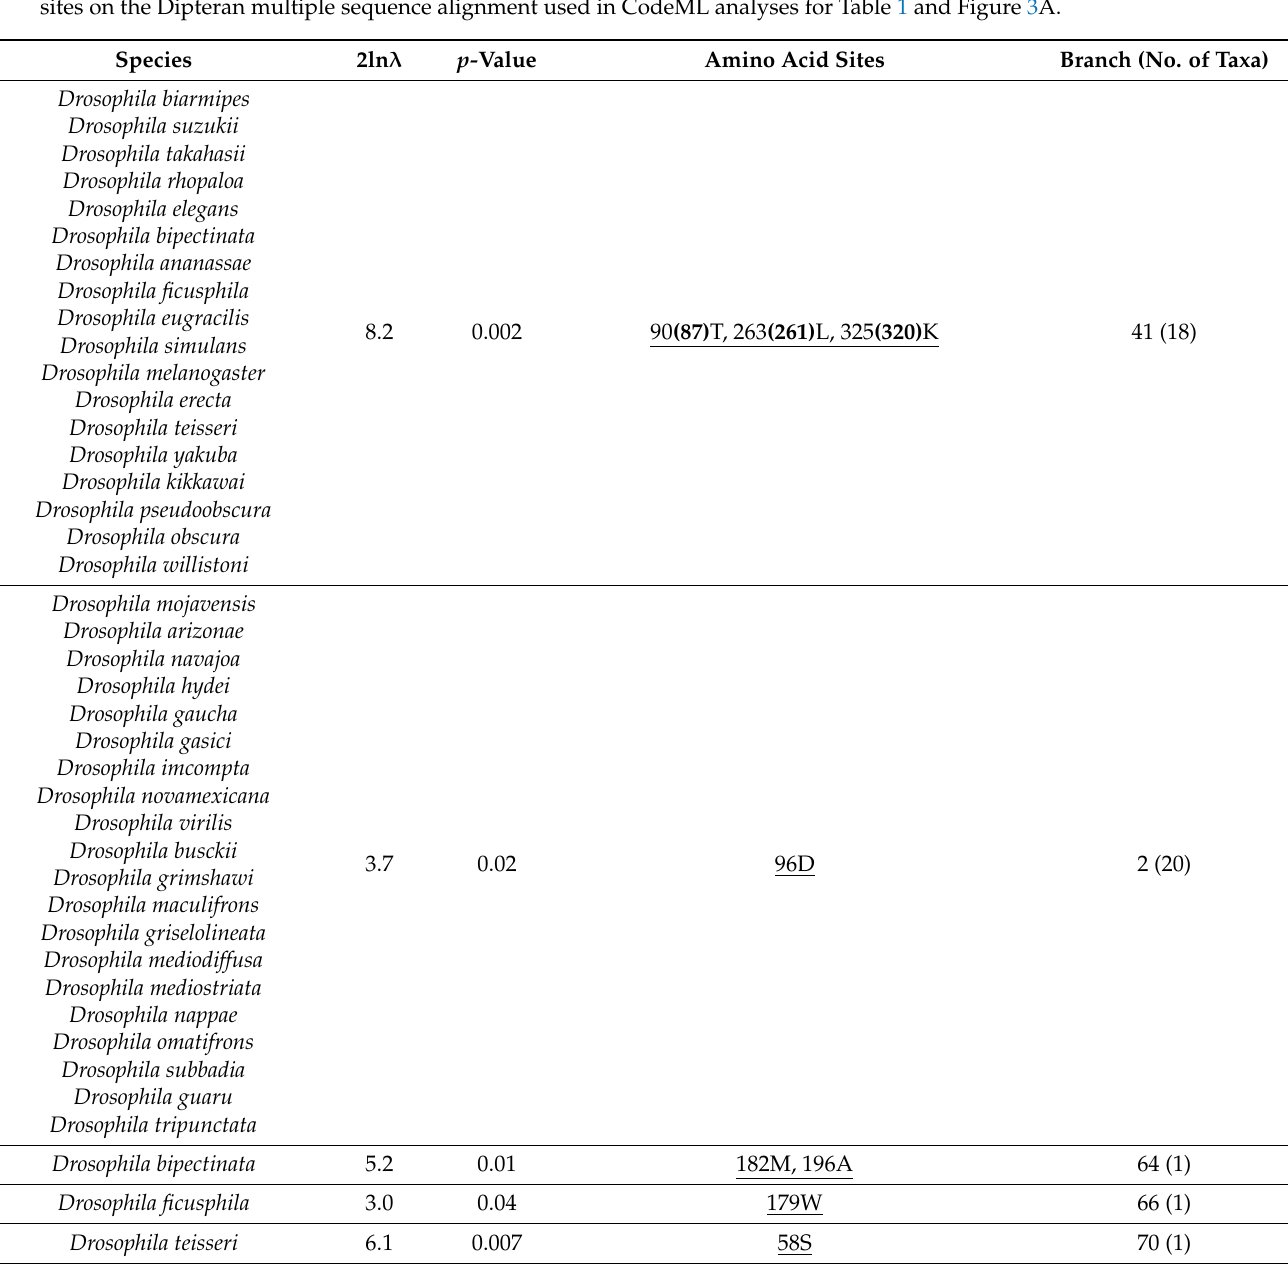
Table 2. CodeML analyses result of positive selection among Drosophilid DNMT2 orthologs. The column “Amino Acid Sites” shows codon positions with BEB posterior probability > 0.95 for having ω > 1. Drosophila melanogaster taxa and associated amino acid sites are represented in bold. The codon sites within parenthesis relate to the positions for the same sites on the Dipteran multiple sequence alignment used in CodeML analyses for Table 1 and Figure 3A. Species 2ln λ p- Value Amino Acid Sites Branch (No. of